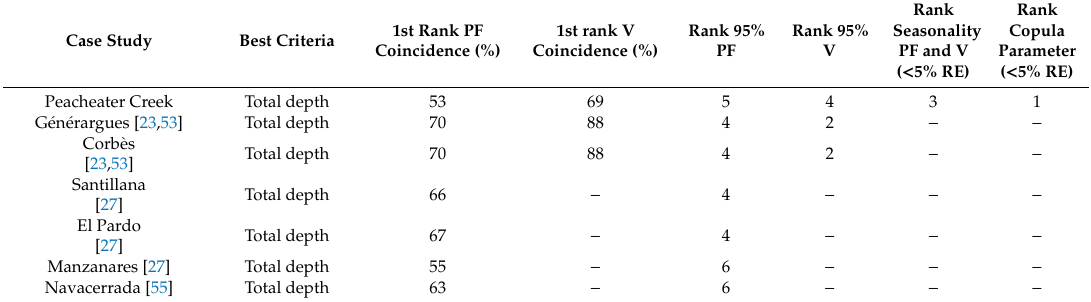
Table 9. Results obtained for the di ff erent case studies considered in Table 8. PF represents the maximum annual peak-flow, V represents the maximum annual volume, and RE represents the relative